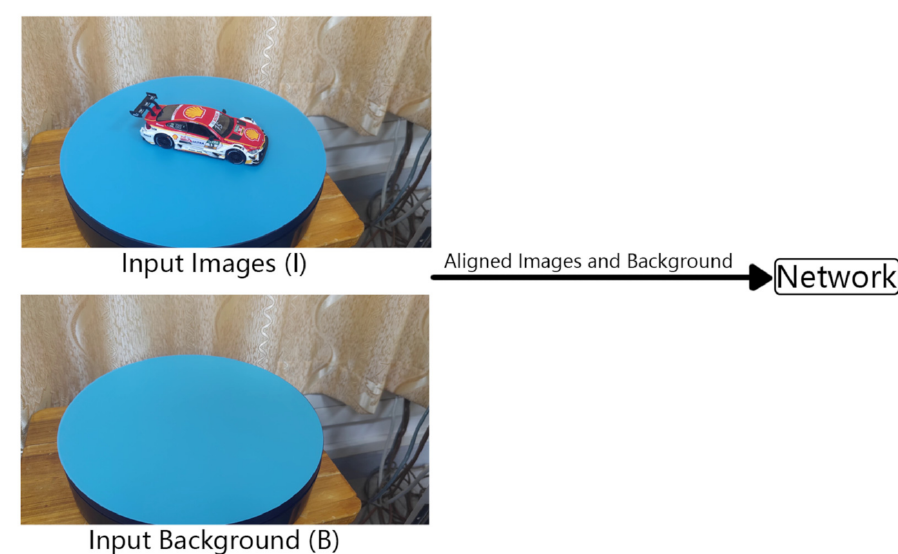
Figure 2. The input video ( I ) and background image ( B ).